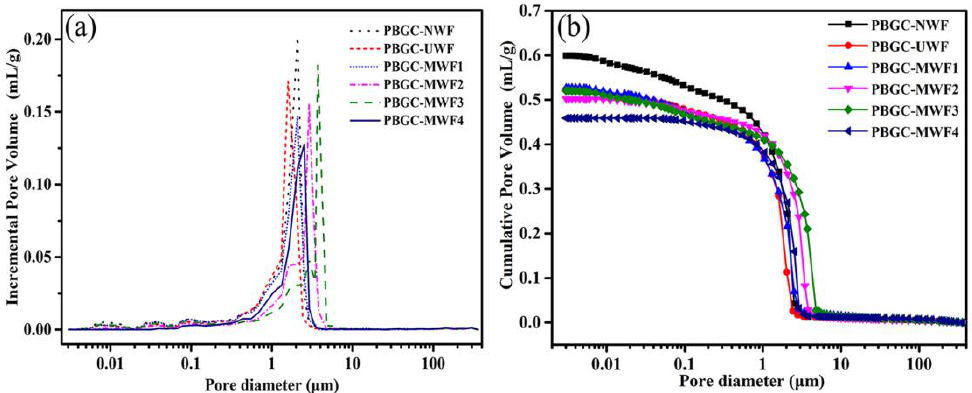
Figure 9. The SEM images of all the PBGC. ( a ) PBGC-NWF; ( b ) PBGC-UWF; ( c ) PBGC-MWF1; ( d ) PBGC-MWF2; ( e ) PBGC-MWF3; ( f ) PBGC-MWF4.